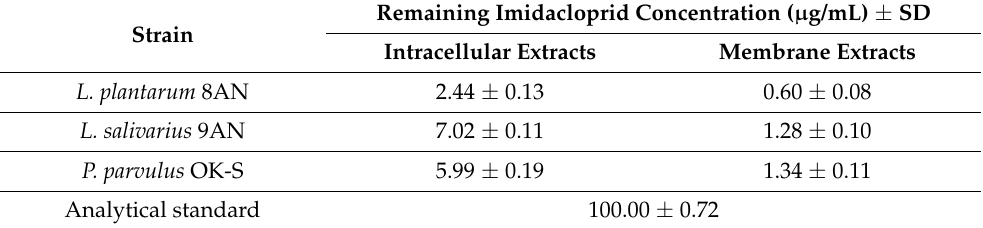
Table 4. Amount of imidacloprid bound to intracellular extracts and membrane extracts after 24 h incubation with selected strains of lactic acid bacteria (LAB). The experiments were conducted for whole live LAB cells. The initial concentration of an individual pesticide was 100 µ g/mL. The presented results are mean from two measurements ±